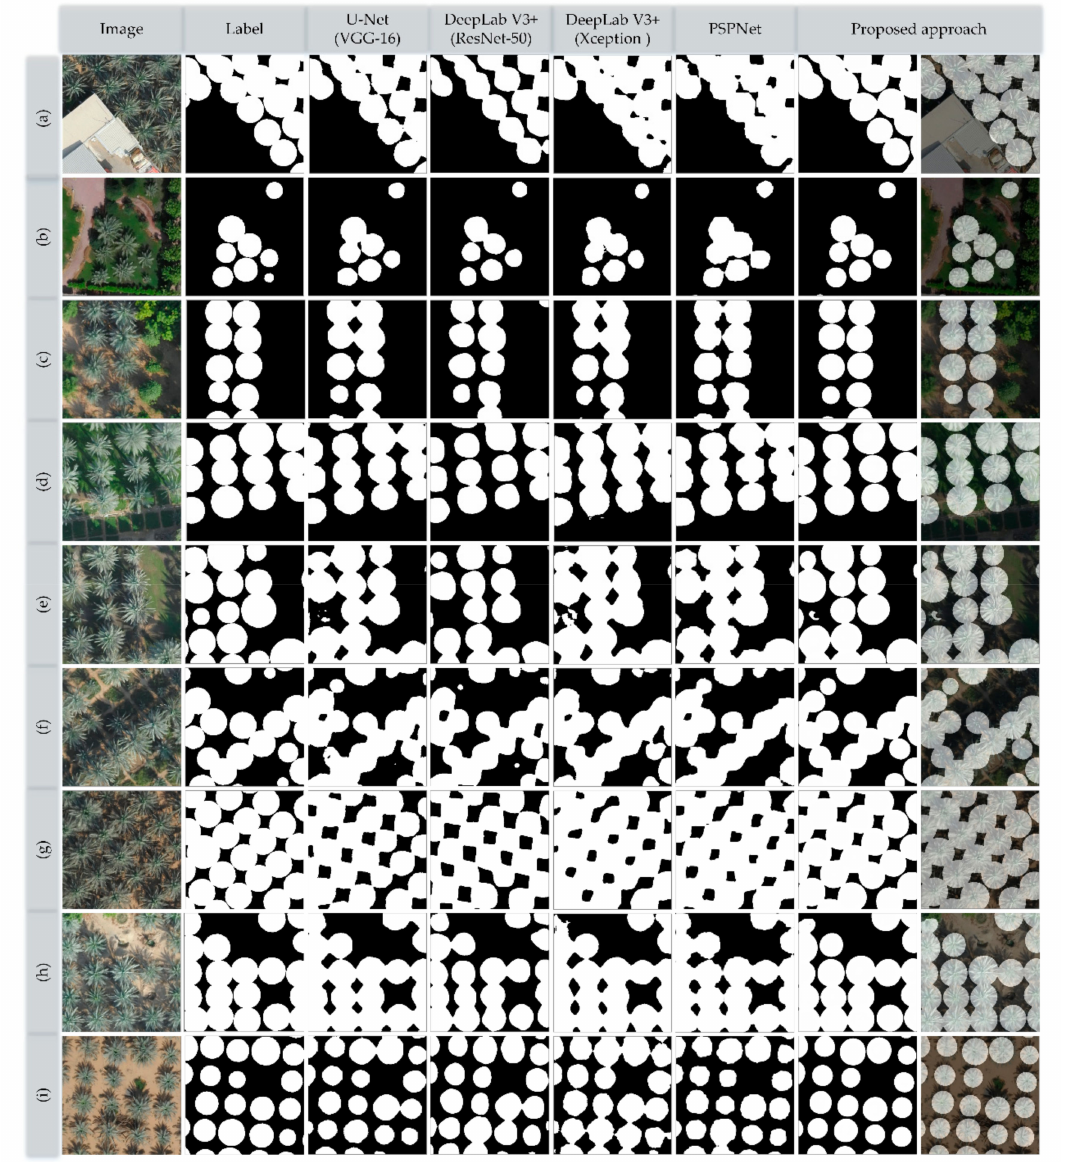
Figure 11. Comparison of nine randomly selected images ( a – i ) from the testing dataset and their corresponding segmentation results. The left side of the figure shows the selected RGB images followed by the corresponding ground truth label and classification results of the evaluated